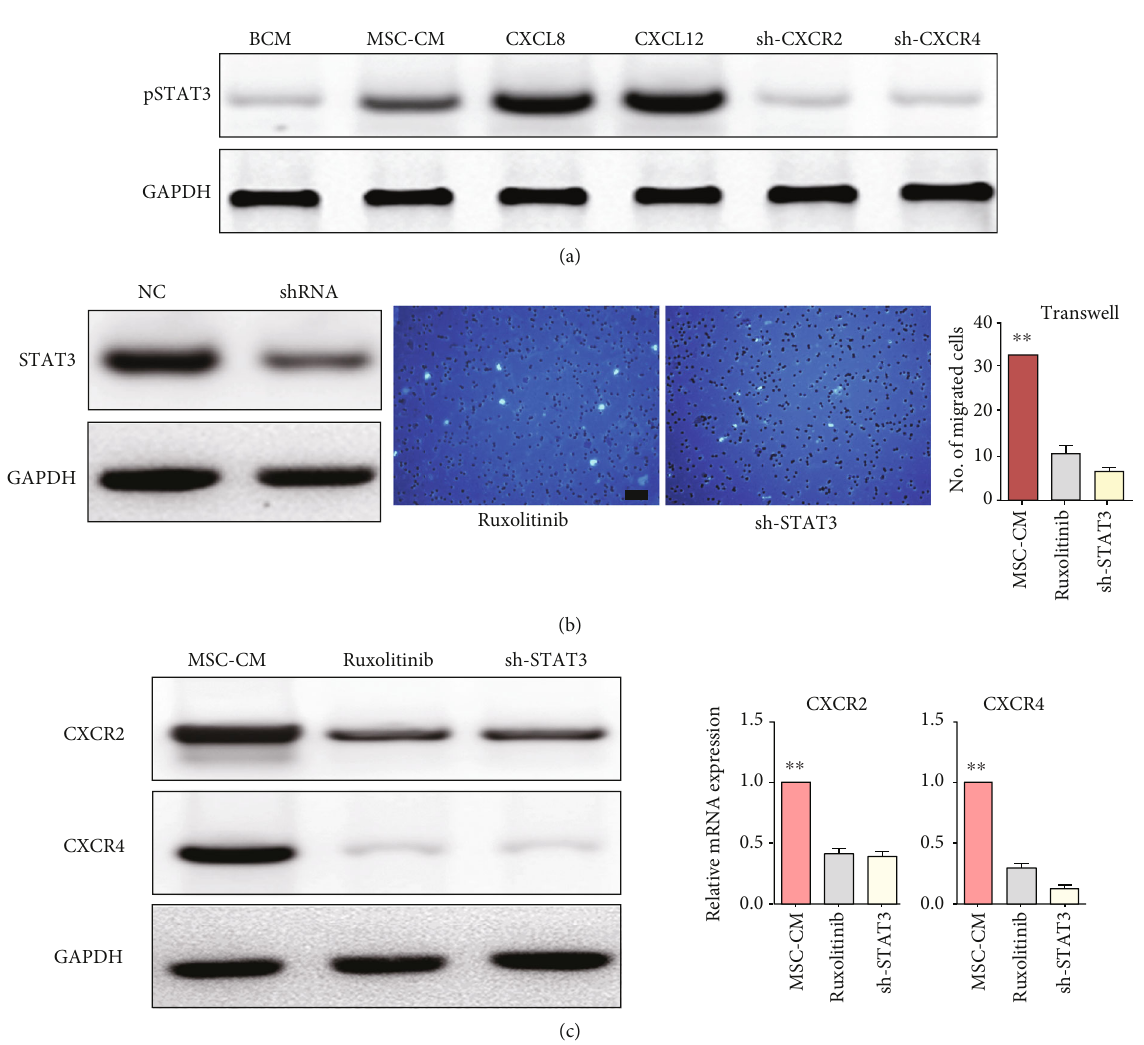
Figure 3: A positive feedback loop of CXCR2/CXCR4-STAT3 existed in EPCs. (a) Changes of STAT3 phosphorylation in EPCs after di ff erent treatments. (b) The e ff ectiveness of shRNA for STAT3. Representative images of migrated EPCs. (c) Changes of protein expressions in EPCs after blockade of STAT3. BCM: basic culture medium; MSC-CM: conditioned media of mesenchymal stem cells. Scale bar, 50 μ m. n = 3 . ∗ p < 0 : 05 and ∗∗ p < 0 : 01